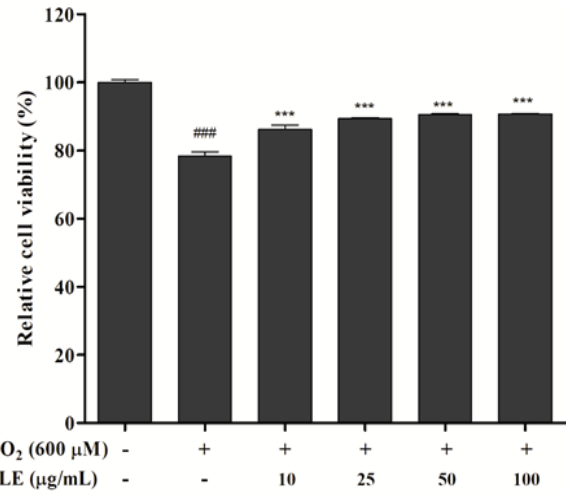
Figure 2. Viability of the H 2 O 2 and/or TLE-treated Vero cells. The data were measured in triplicate and expressed as the mean ± SE. *** p < 0.001 compared with the H 2 O 2 -treated group and ### p < 0.001 compared with the untreated